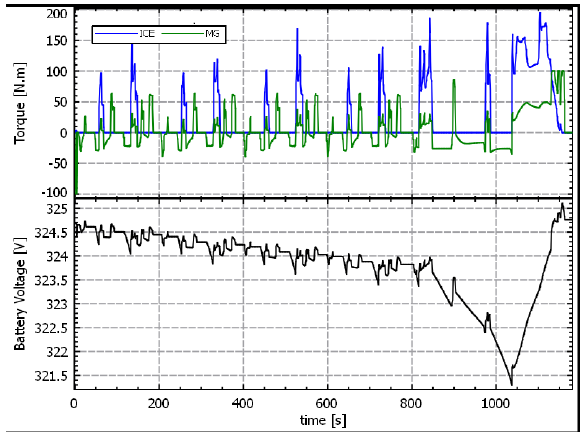
Figure 5. Engine Map, Torque and SoC results.